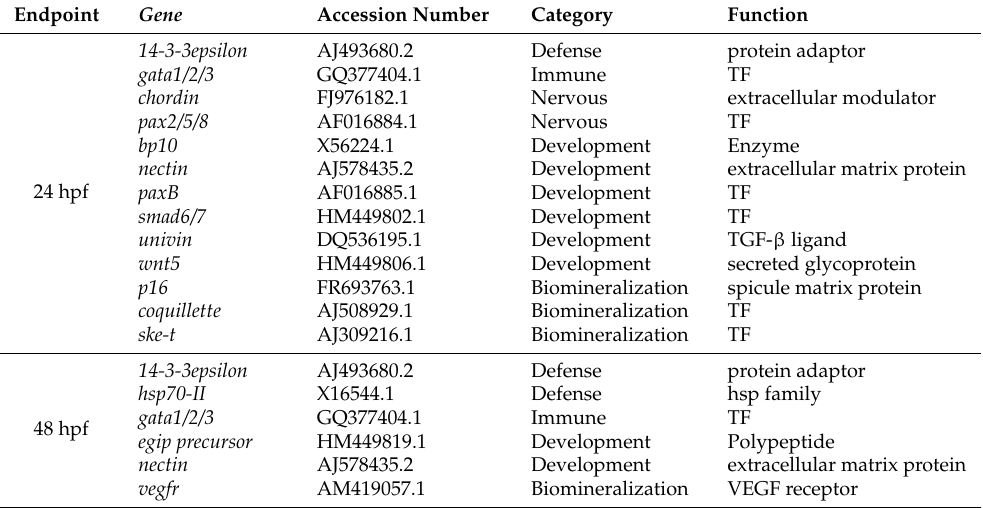
Table 1. List of sensitive genes common to Li, Ni and Zn as potential biomarkers of impact.